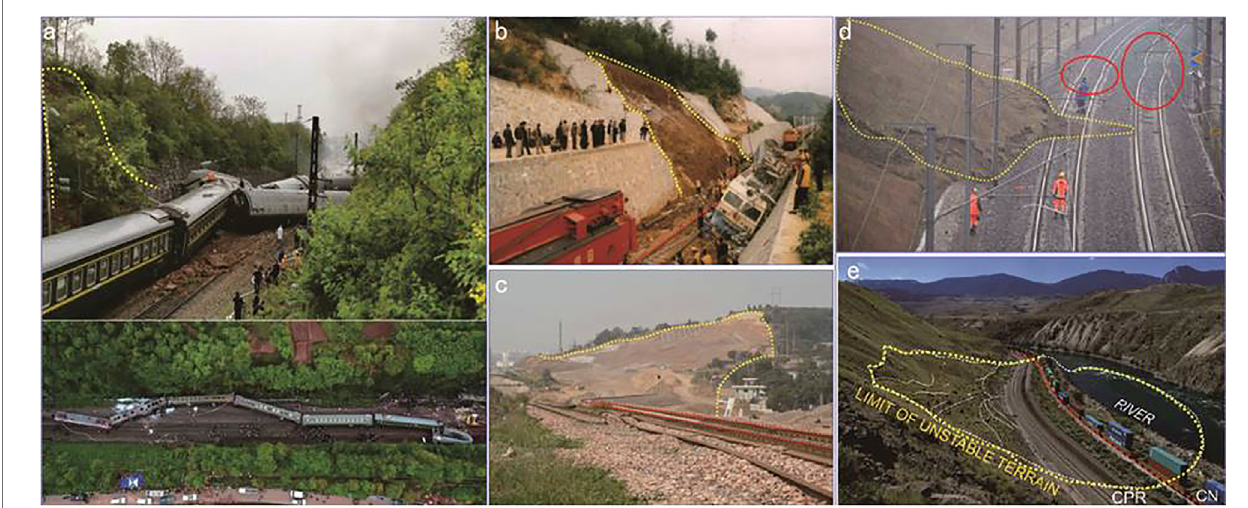
FIGURE 2 | New geological hazards induced by vibration, rainfall, or the coupling effect. (A) Landslide in the Yonghua section of the Beijing – Guangzhou Railway. (B) Typical landslides along a heavy-load railway in Shanxi. (C) Landslide along the Yang-Da Railway (Wang et al., 2021). (D) Landslides along the section close to Strasbourg at the France and Germany border as TGV (Train À Grande Vitesse) is approaching (https://www.sohu.com/a/377989394_100016456). (E) Landslides along the railway near Ashcroft, Canada (Huntley et al., 2019).